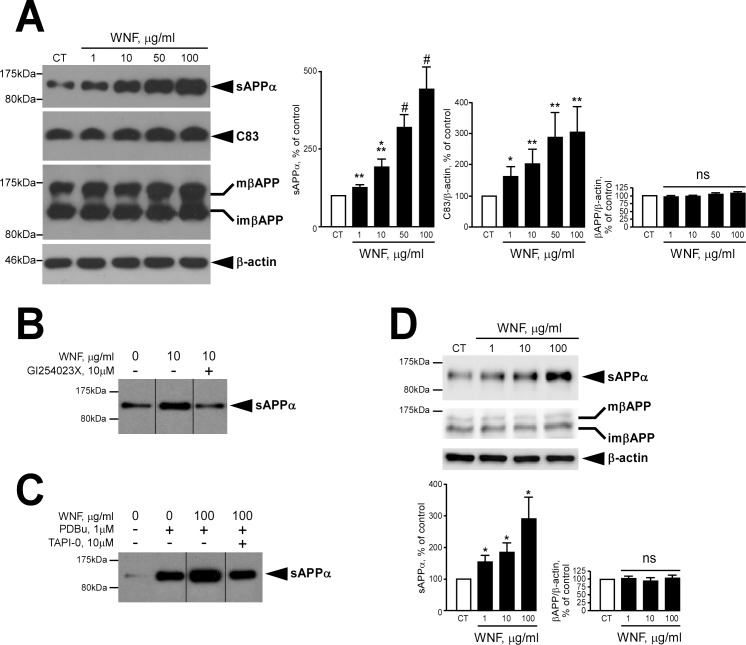
WNF stimulates sAPPα production in human HEK293 cells.(A) Cultured βAPP751-HEK293 cells were incubated without (control) or with the indicated concentrations of WNF (in 1ml DMEM/1% FBS) for 16 hours at 37°C. After secretion for 1 hour (in 1ml serum-free DMEM), media and cell lysates were collected and sAPPα (n = 8), βAPP (n = 8), C83 (n = 6) and β-actin were analyzed by Western blot. (B, C) Cells were treated with the indicated WNF concentrations for 16 hours, subsequently stimulated (+) or not (-) for 2 hours with PDBu (1μM) (C) and then incubated for 30 min in the absence (-) or in the presence (+) of GI254023X (10μM) (B) or TAPI-0 (10μM) (C). Measure of sAPPα secretion and detection were performed as in (A). (D) Wild-type HEK293 cells were treated as in (A) and allowed to secrete for 5 hours before sAPPα (medium, n = 4) as well as βAPP (n = 4) and β-actin (lysate) were analyzed by Western blot. *p<0.05; **p<0.02; ***p<0.001; #p<0.0001; ns, non-statistically different. Immunoblots illustrate representative gels and histograms correspond to the statistical analysis for all experiments. All bars correspond to the densitometry analyses (βAPP and C83 being normalized with β-actin), are expressed as a percentage of control (white bars, non treated cells) taken as 100 and are the means ± SE of the indicated number of independent experiments. Black lines in (B) and (C) indicate when lanes from the same original gels were spliced for better clarity.